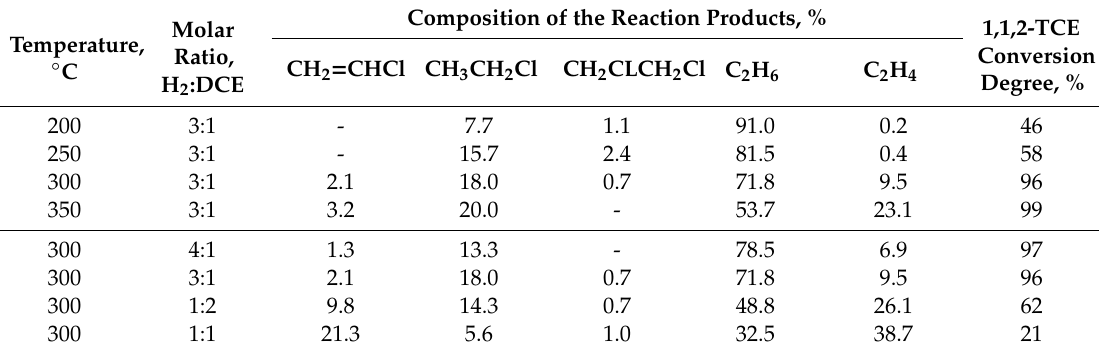
Table 7. Influence of temperature and reagents ratio on composition of 1,1,2-trichloroethane hydrodechlorination products. Residence time: 18